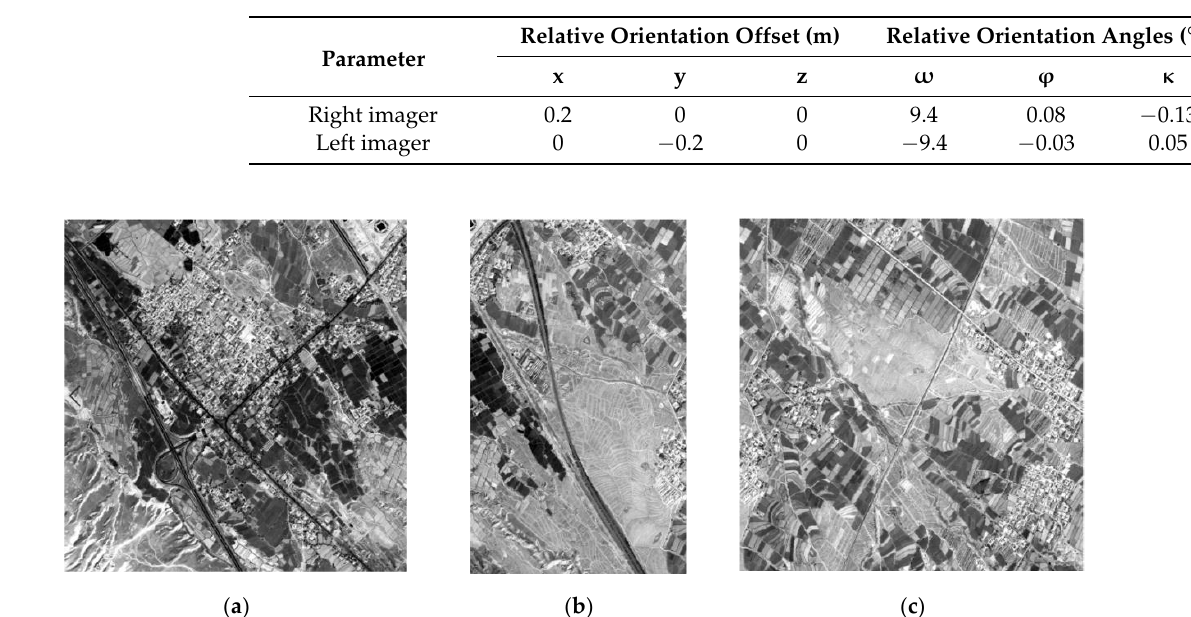
Figure 6. Simulation images: ( a ) Left image; ( b ) Middle image; ( c ) Right image.